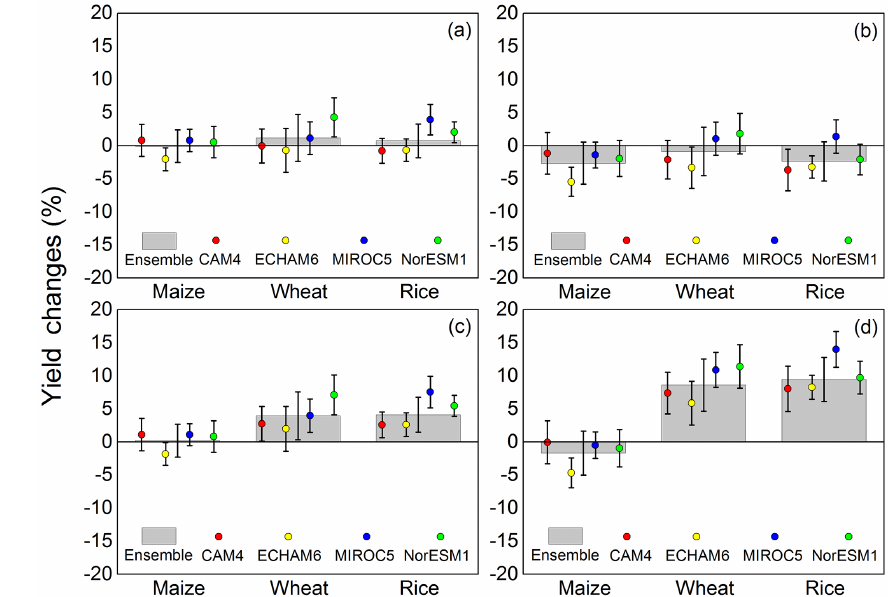
Figure 6. Projected yield change using climate projection from different GCMs at a country scale during 2106–2115 in the warming scenarios of 1.5 ◦ C (a, c) and 2.0 ◦ C (b, d) relative to 2006–2015, without (a, b) and with (c, d) the CO 2 fertilization